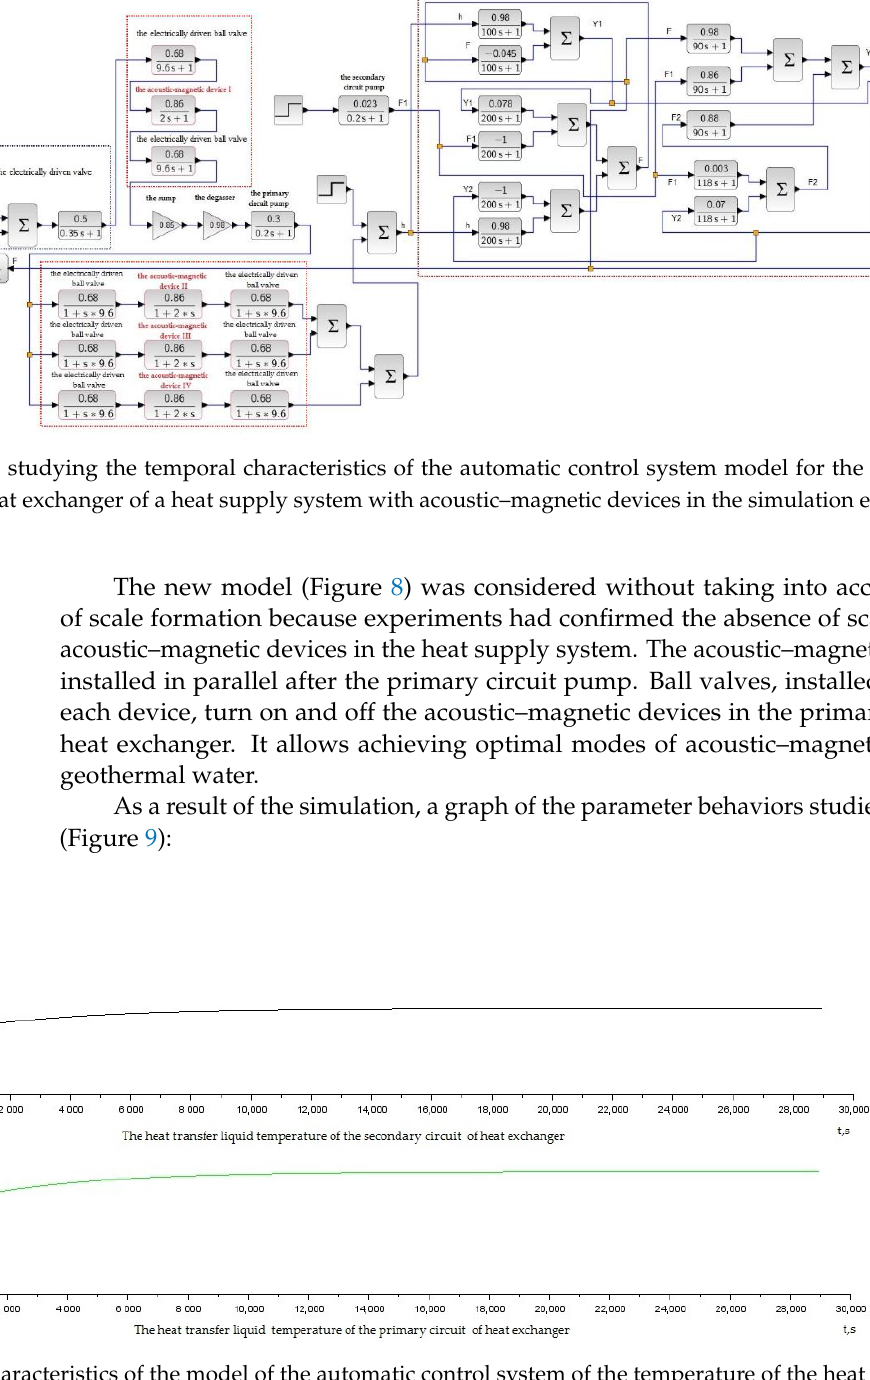
Figure 7. Transient characteristics of the model of the automatic control system of the temperature of the heat carrier without an acoustic–magnetic device.